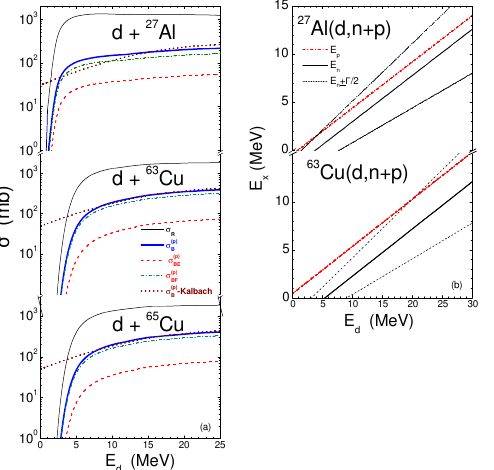
Fig. 2. (Color online) (a) The energy dependence of the to- tal (thick solid), the elastic (dashed), the inelastic (dot-dashed) proton-emission breakup cross sections given by [1] and of the total proton-emission breakup cross sections [12] (dotted) from the deuterons interactions with 27 Al and 63 , 65 Cu. The correspond- ing total reaction cross section is shown by thin curve. (b) The centroid E x of assumed Gaussian line shape [12] for deuteron breakup-peak energies of emitted neutrons (solid) and protons (dash-dotted), and the corresponding E n ± ∆ values (dashed) cal- culated for deuterons interacting with 27 Al and 63